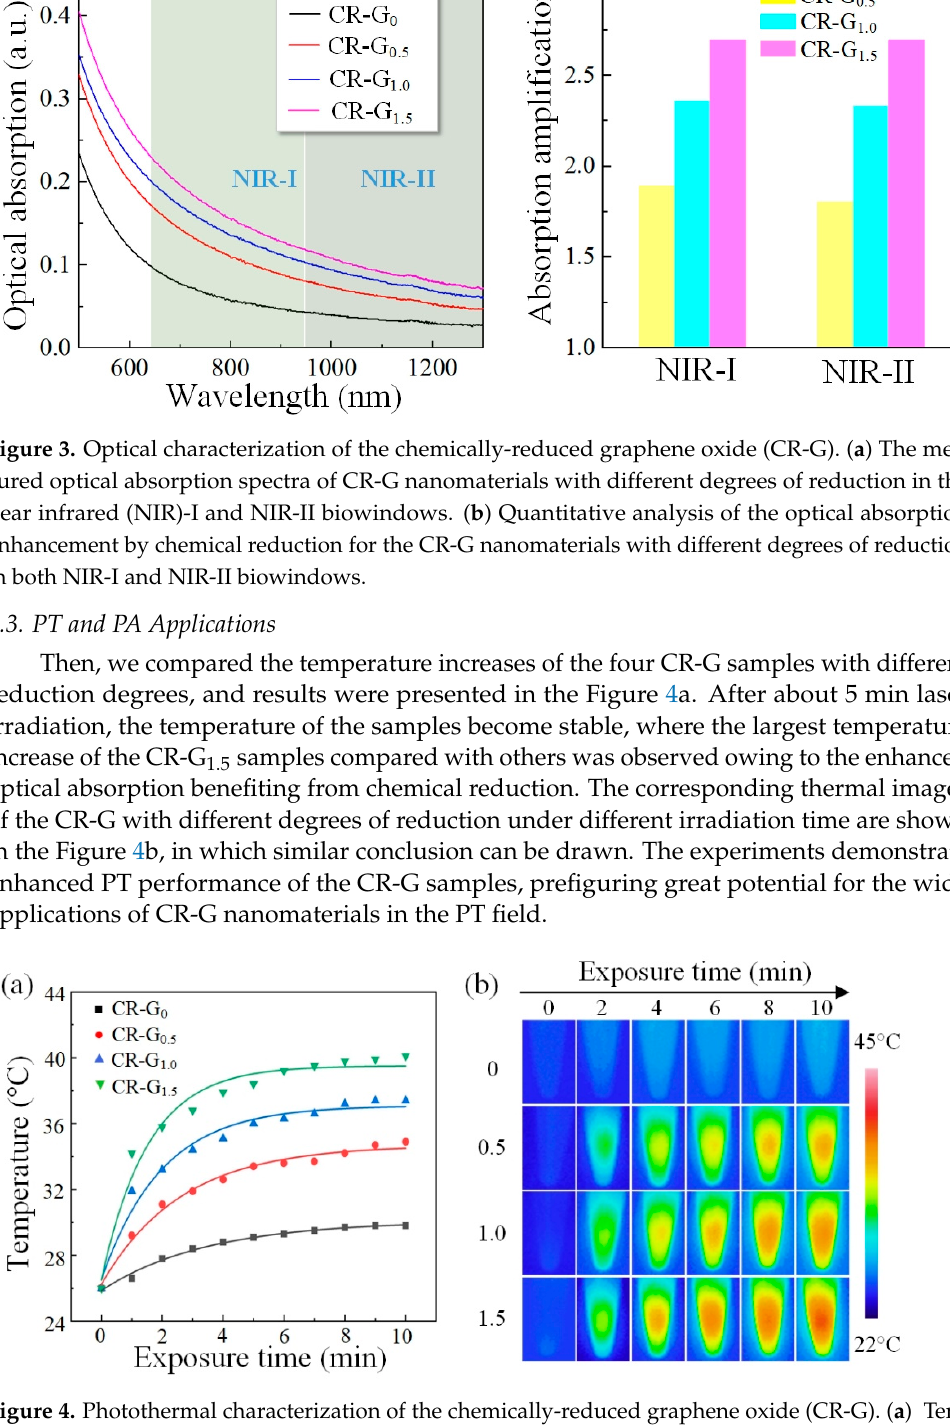
Figure 4. Photothermal characterization of the chemically-reduced graphene oxide (CR-G). ( a ) Tem- perature of the CR-G nanomaterials with different degrees of reduction as a function of 980 nm laser exposure time. ( b ) The thermal images of the CR-G nanomaterials with different degrees of reduc- tion as a function of exposure time.